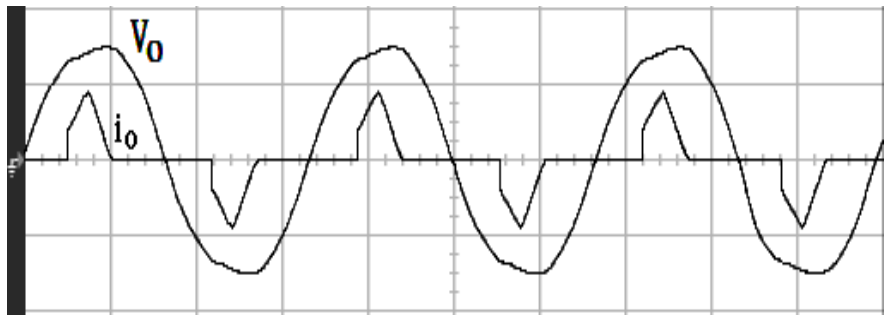
Figure 12. Output voltage and current for experiment of the proposed solution under rectifier load (vertical: 100 V/div and 25 A/div; horizontal: 5 ms/div). Table 2. %THD of output voltage.